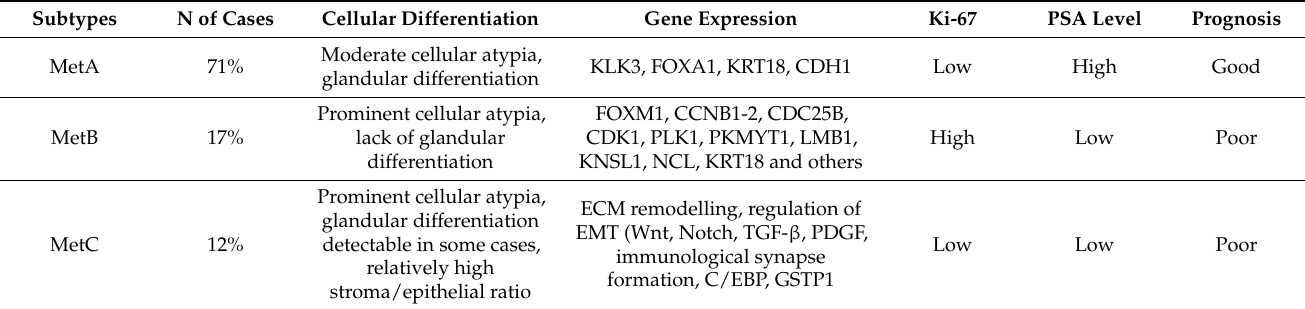
Table 2. Molecular subtypes of prostate cancer bone metastases